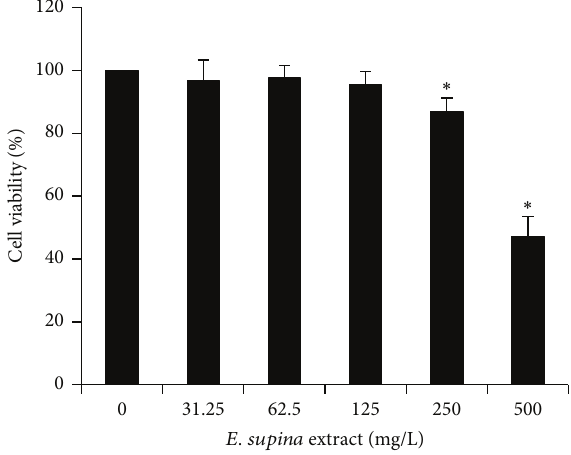
Figure 3: Antiproliferation effect on Hep3B cells by the Euphorbia supina polyphenol mixture. Hep3B cells were treated with the indi- cated concentrations of the E. supina polyphenol mixture for 24 h and viability was determined using 3-(4,5-dimethylthiazol-2-yl)- 2,5-diphenyltetrazolium bromide (MTT) assay. Data represent the mean ± standard deviation (SD) of three replicates of independent experiments. The asterisk ( ∗ ) indicates a significant difference from the control group ( 𝑃 < 0.05